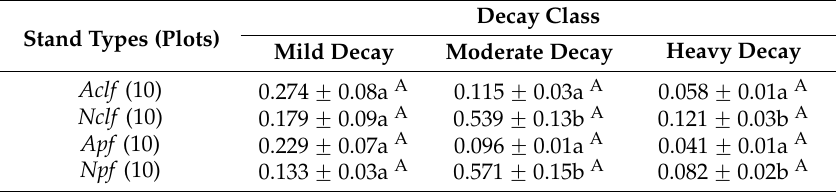
Table 5. Biomass of fallen trees of decay classes in different stand and forest types. Decay Class Stand Types (Plots) Mild